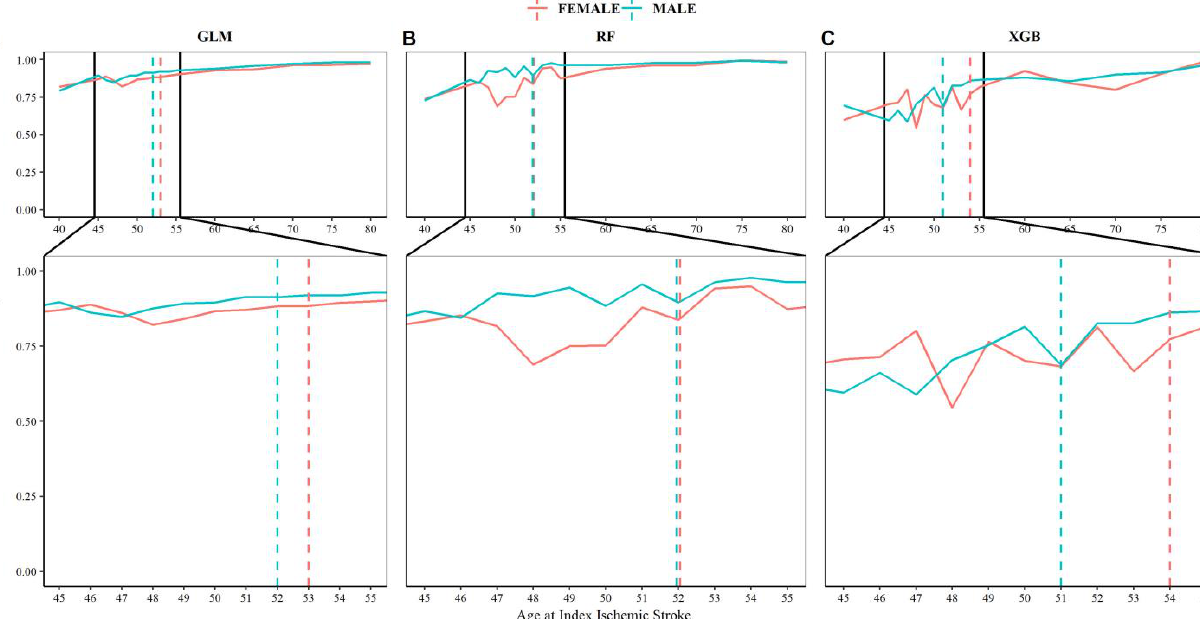
Figure 4. The trend of cosine similarity versus age at index ischemic stroke. Lower cosine similarity scores were indicative of increased dissimilarity, suggesting a change in risk factor profile across that age cutoff. ( A ) Cosine similarity trend for GLM model. ( B ) Cosine similarity trend for RF model. ( C ) Cosine similarity trend for XGB model.